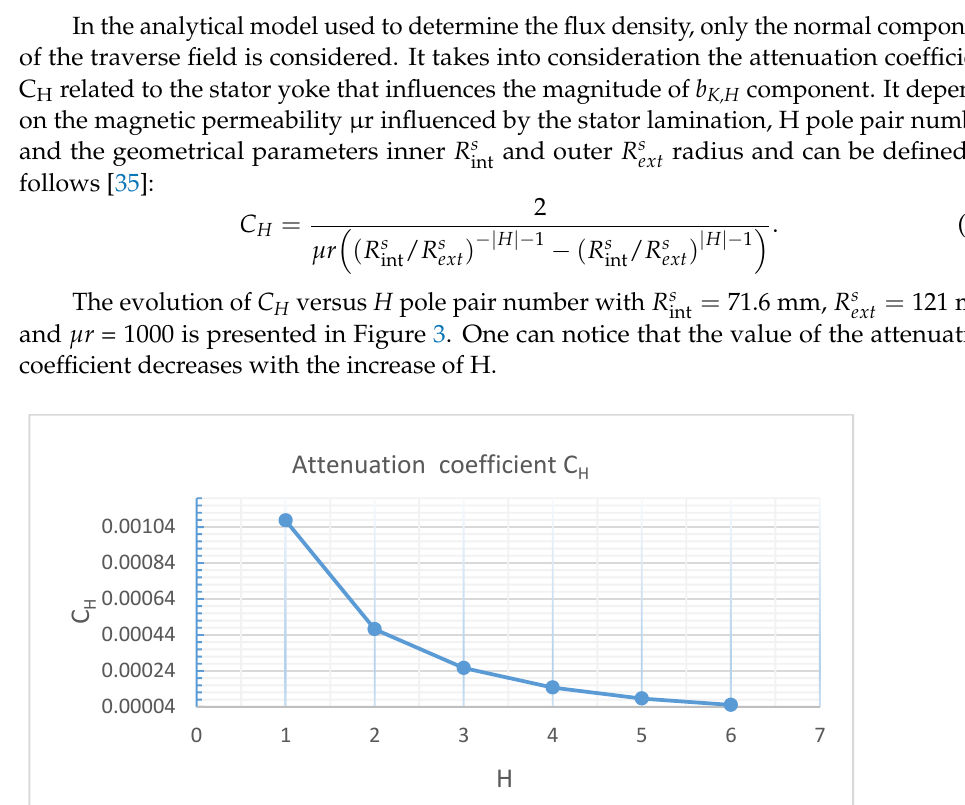
Figure 2. Geometrical parameters of machine used in the analytical model.